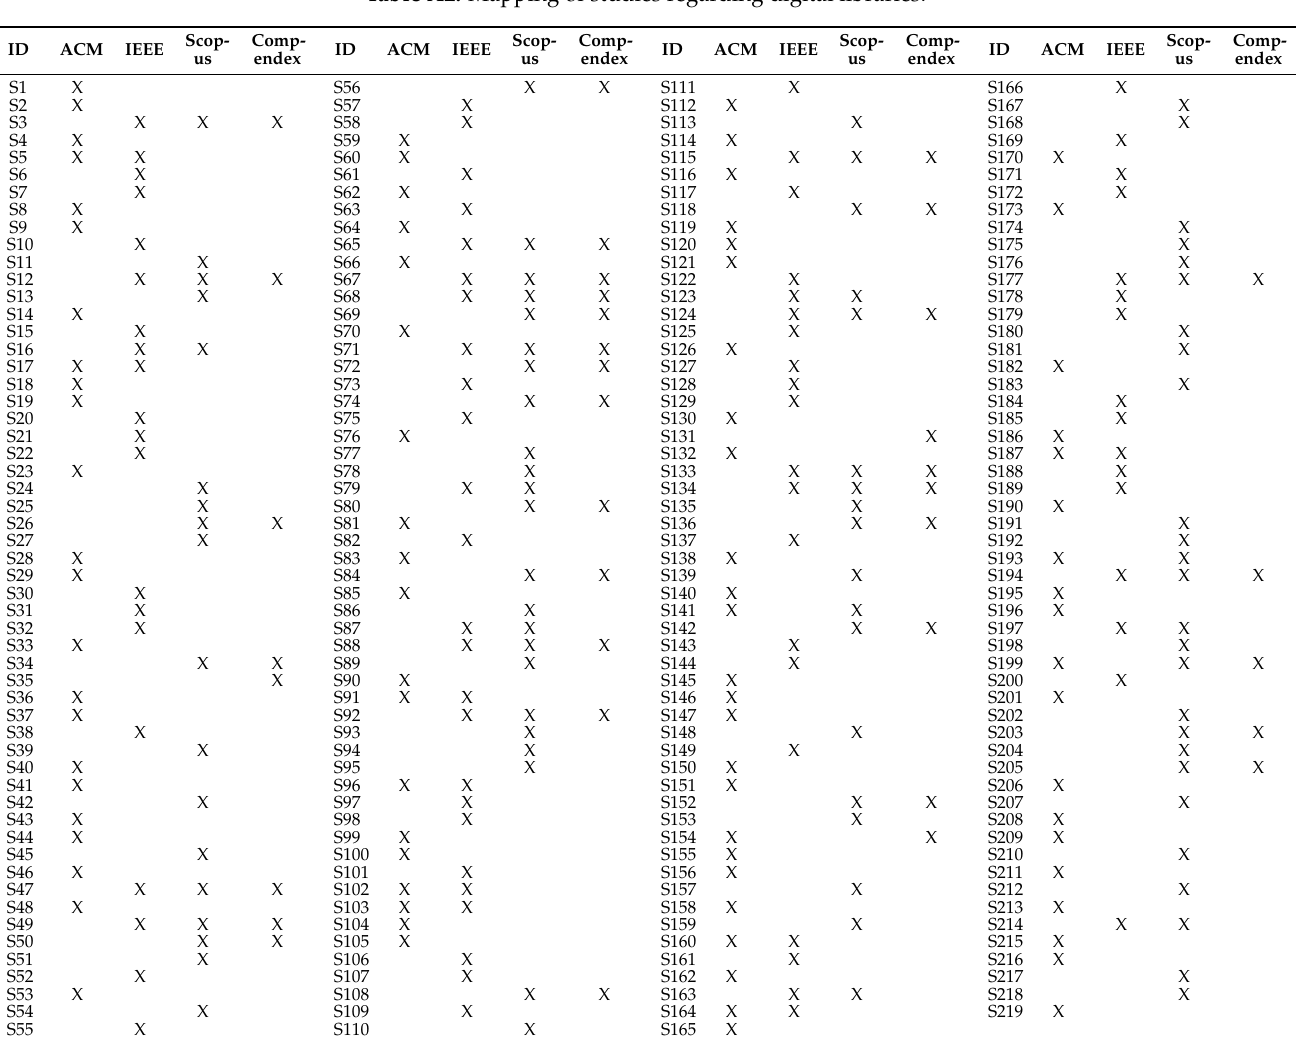
Table A2. Mapping of studies regarding digital